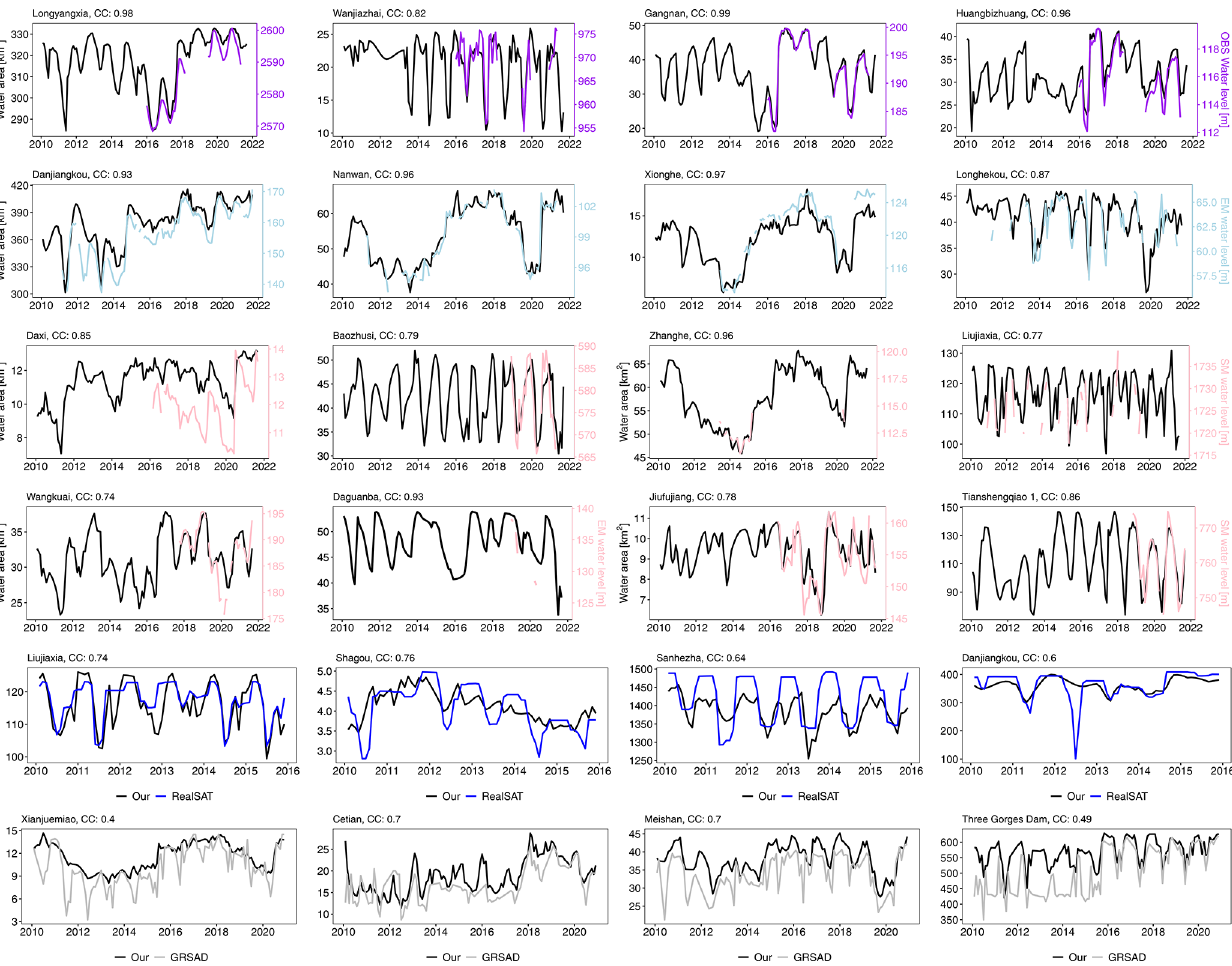
Figure 7. Illustration of reservoir water area time series against in situ water level, altimetric water level from standard measurement and enhanced measurement, and GRSAD and ReaLSAT area time series at a selected sample of reservoirs with varying area size. The time series for other reservoirs are all available in the